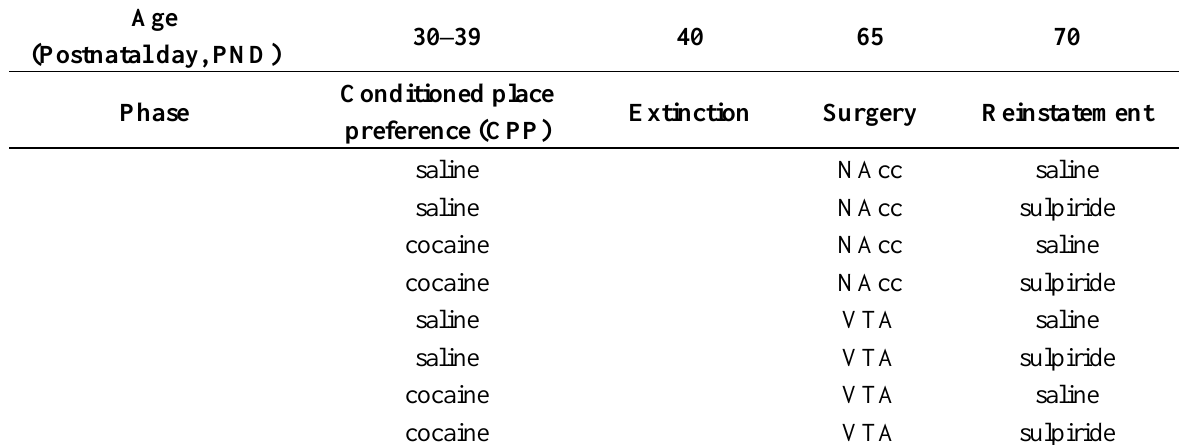
Table 1. Experimental